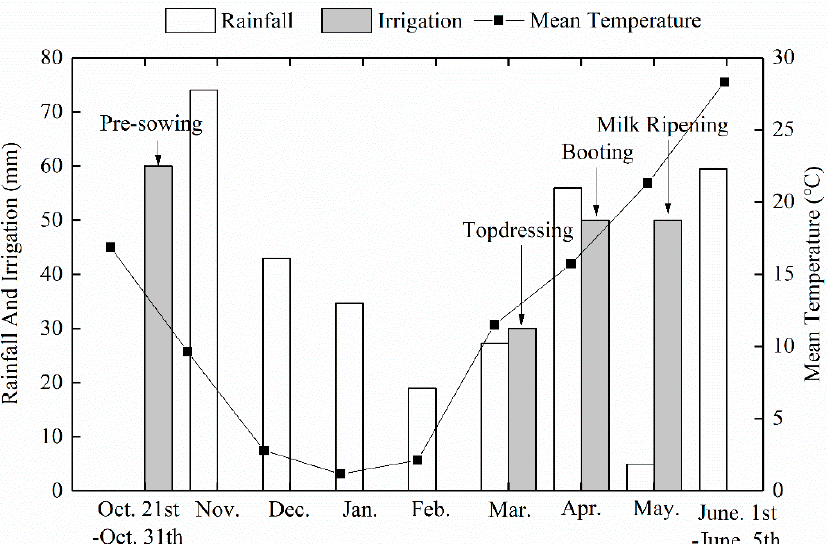
Figure 3. Rainfall and irrigation and mean temperature recorded during the 2018 to 2019 wheat growing seasons in Fengqiu Agro-ecological experimental station, CAS.